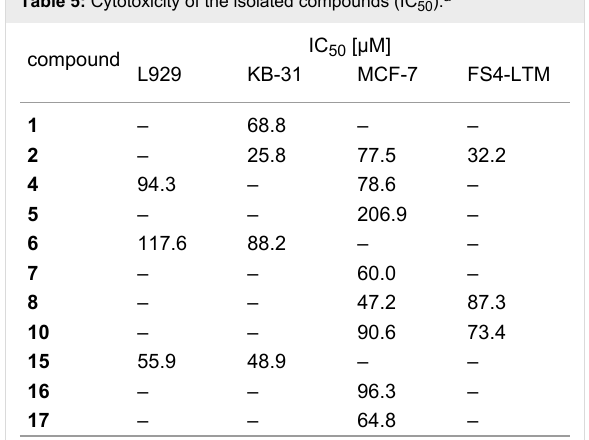
Table 5: Cytotoxicity of the isolated compounds (IC 50 ).